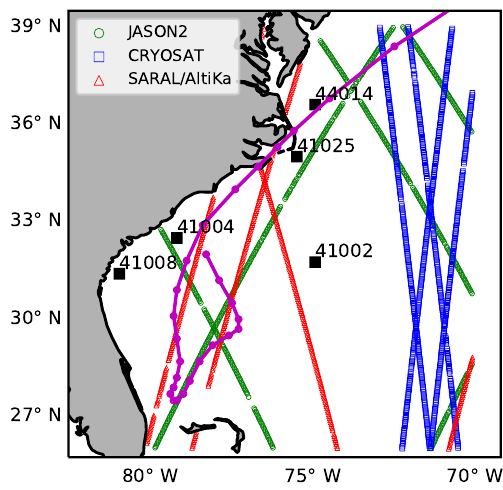
Figure 6. Altimeter tracks for JASON2 (green), CRYOSAT (blue), and SARAL/Altika (red) for the analysis period within the study re- gion. The location of considered NDBC buoys are marked in black, and the observed track of Hurricane Arthur (2014) is overlaid in magenta. Table 1. Summary of numerical model experiments with different coupling configurations. Experiment Wave Spray Spray coupling heat fluxes